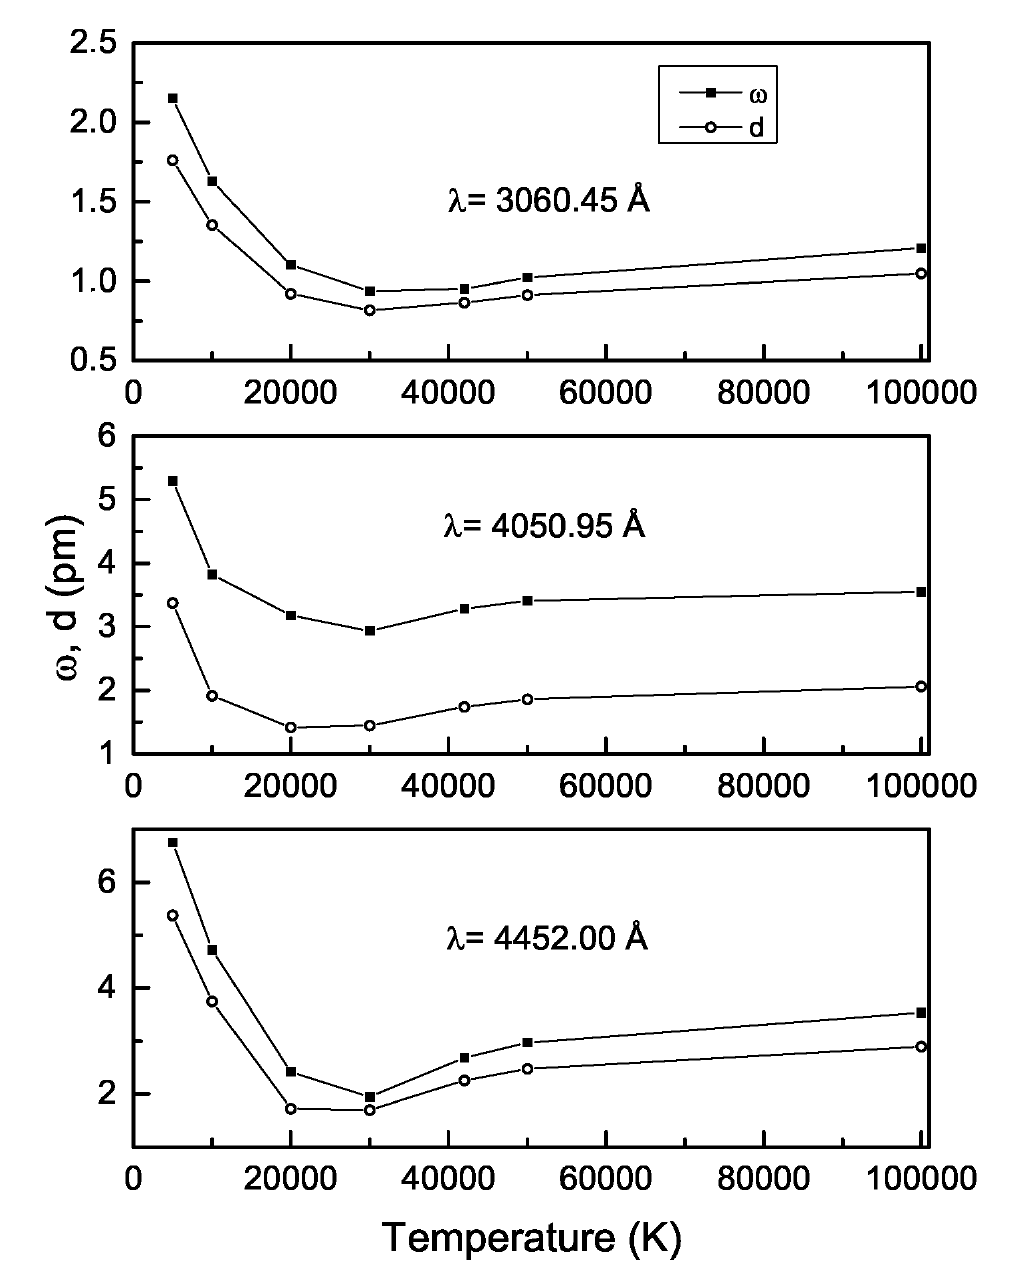
Figure 1. Calculated Stark width (full-width at half maximum (FWHM)) ω (pm), and shifts (d(pm)) normalized to Ne = 10 15 cm − 3 vs. temperature for spectral lines of neutral vanadium of astrophysical